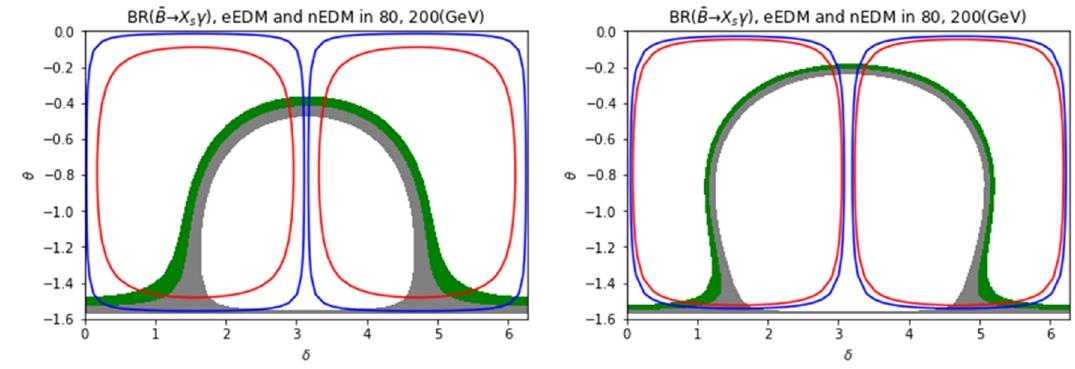
Figure 12 . The allowed regions from ¯ B → X s γ (within the green and grey shaded areas), eEDM (outside the blue curves), and nEDM (outside the red curves) in the [ δ, θ ] plane, with M = 80 GeV, M = 200 GeV, tan γ = 1 , and tan β = 5 (left) or 10 (right). Here, the shaded H + 2 H + 3 areas correspond to the ± 2 σ allowed region of BR( ¯ B → X s γ ), with the green (grey) area corre- sponding to values below (above) the experimental central